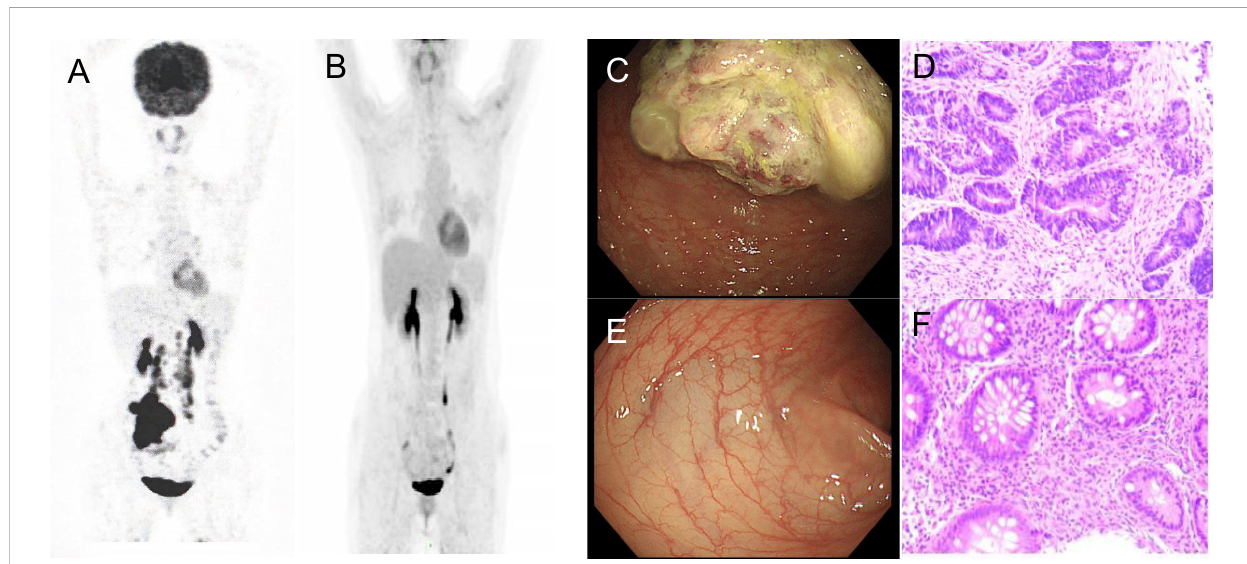
FIGURE 1 PET/CT and coloscopy fi ndings at baseline and after treatment. PET/CT showed disease status (A) before treatment and (B) after treatment. (C) The coloscopy showed the tumor in the right colon. (D) Immunohistochemistry of pre-treatment biopsy con fi rmed tumor cells. (E) Post-treatment coloscopy did not display any neoplasm. (F) Pathologic analysis of the tissue manifested chronic